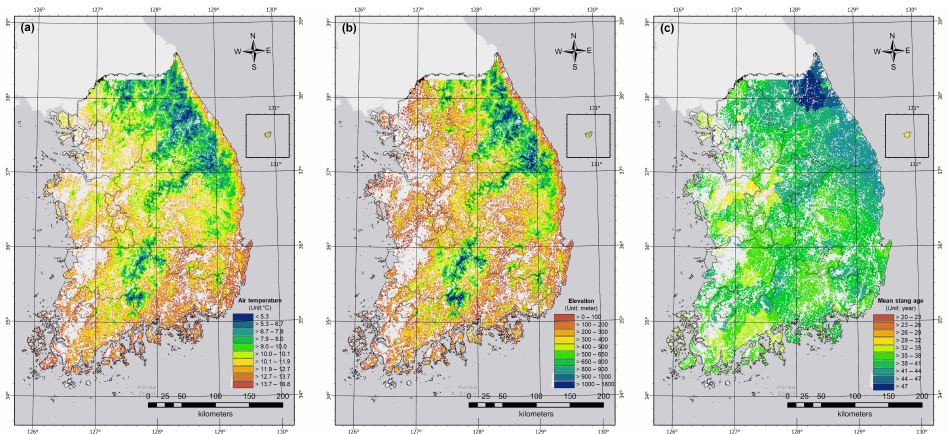
Figure 1. South Korean forest maps of ( a ) mean annual air temperature during 1991–2020, ( b ) elevation, and ( c ) mean stand age during the seventh national forest inventory survey period (2016–